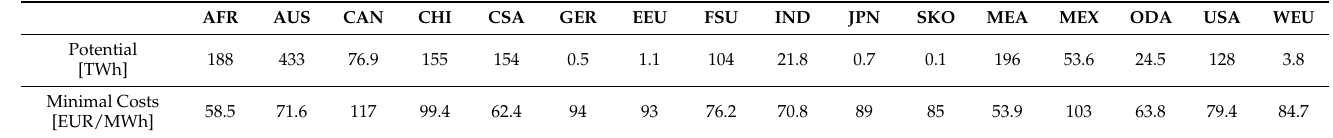
Table 2. Liquid green hydrogen export potentials and costs per region in 2050